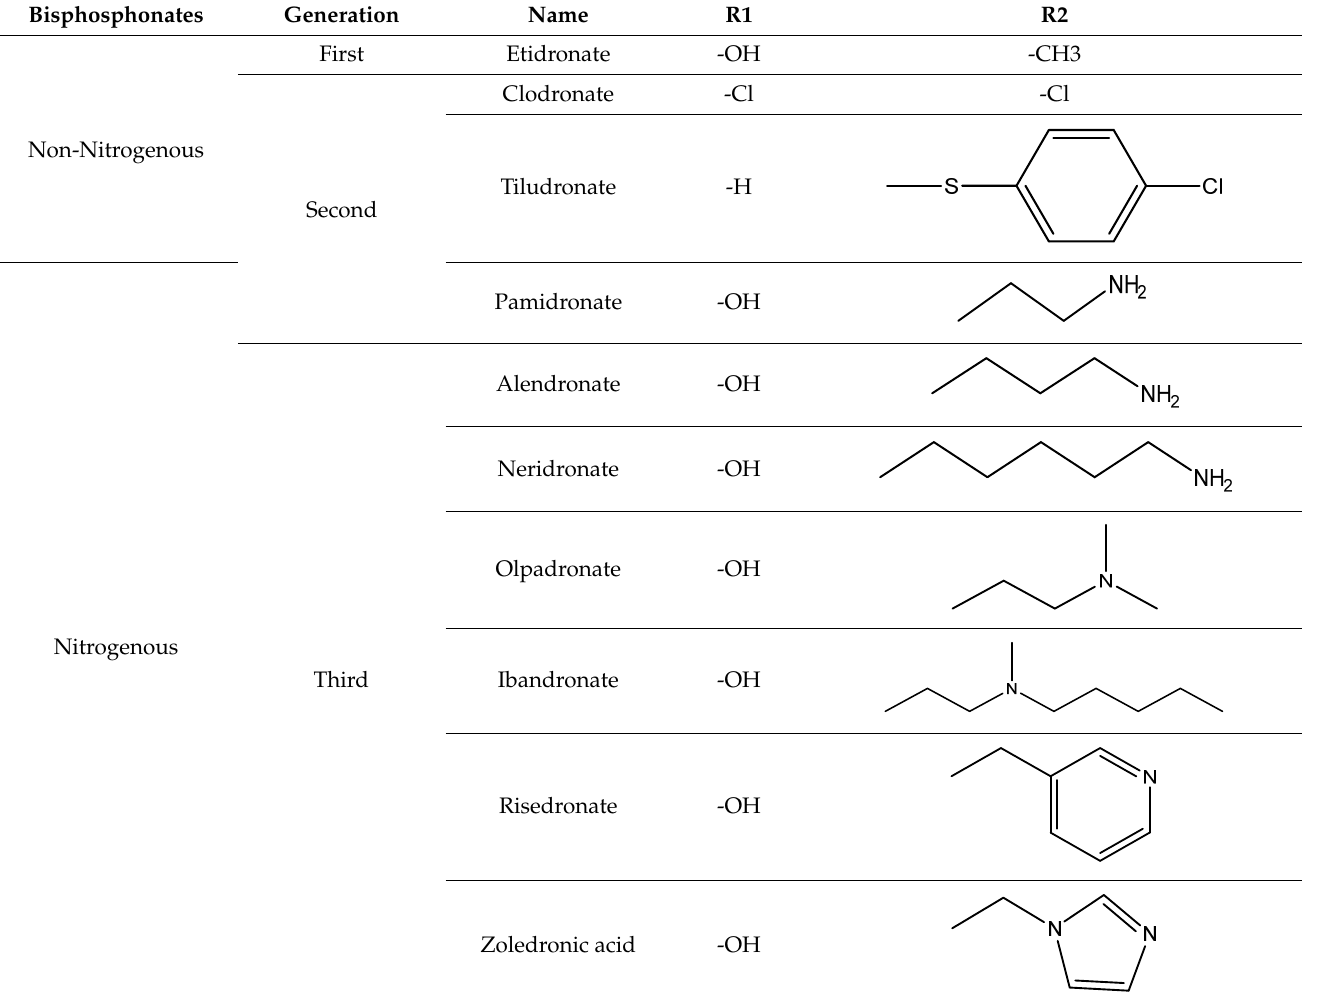
Table 2. Differences among three generations of bisphosphonates.